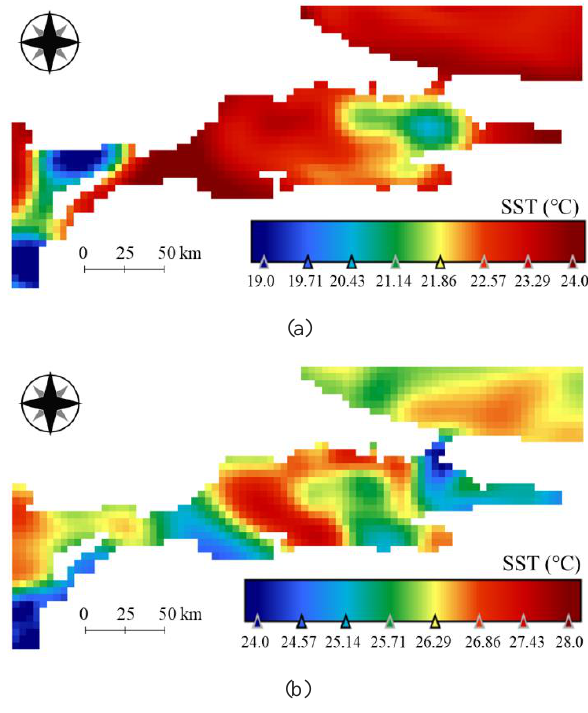
Figure 7. Thematic map of SST derived from the